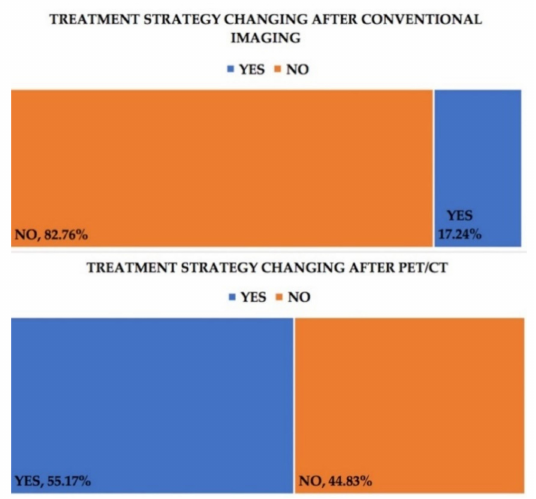
Figure 3. Treatment strategy change post-conventional imaging (upper chart) compared with F18- FDG PET-CT (lower chart).